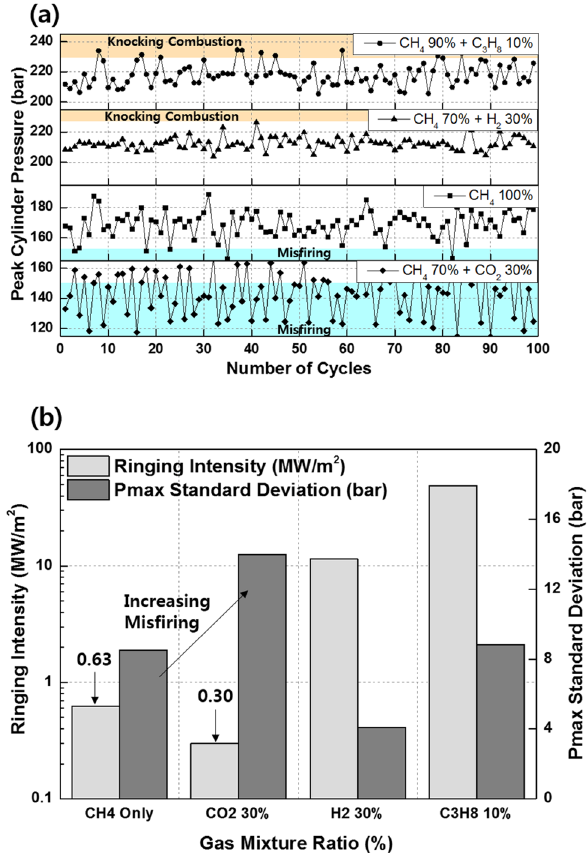
Figure 22. Effects of the premixed gas compositions on the ( a ) cycle to cycle variation in the peak cylinder pressure and ( b ) RI and STD of the peak cylinder